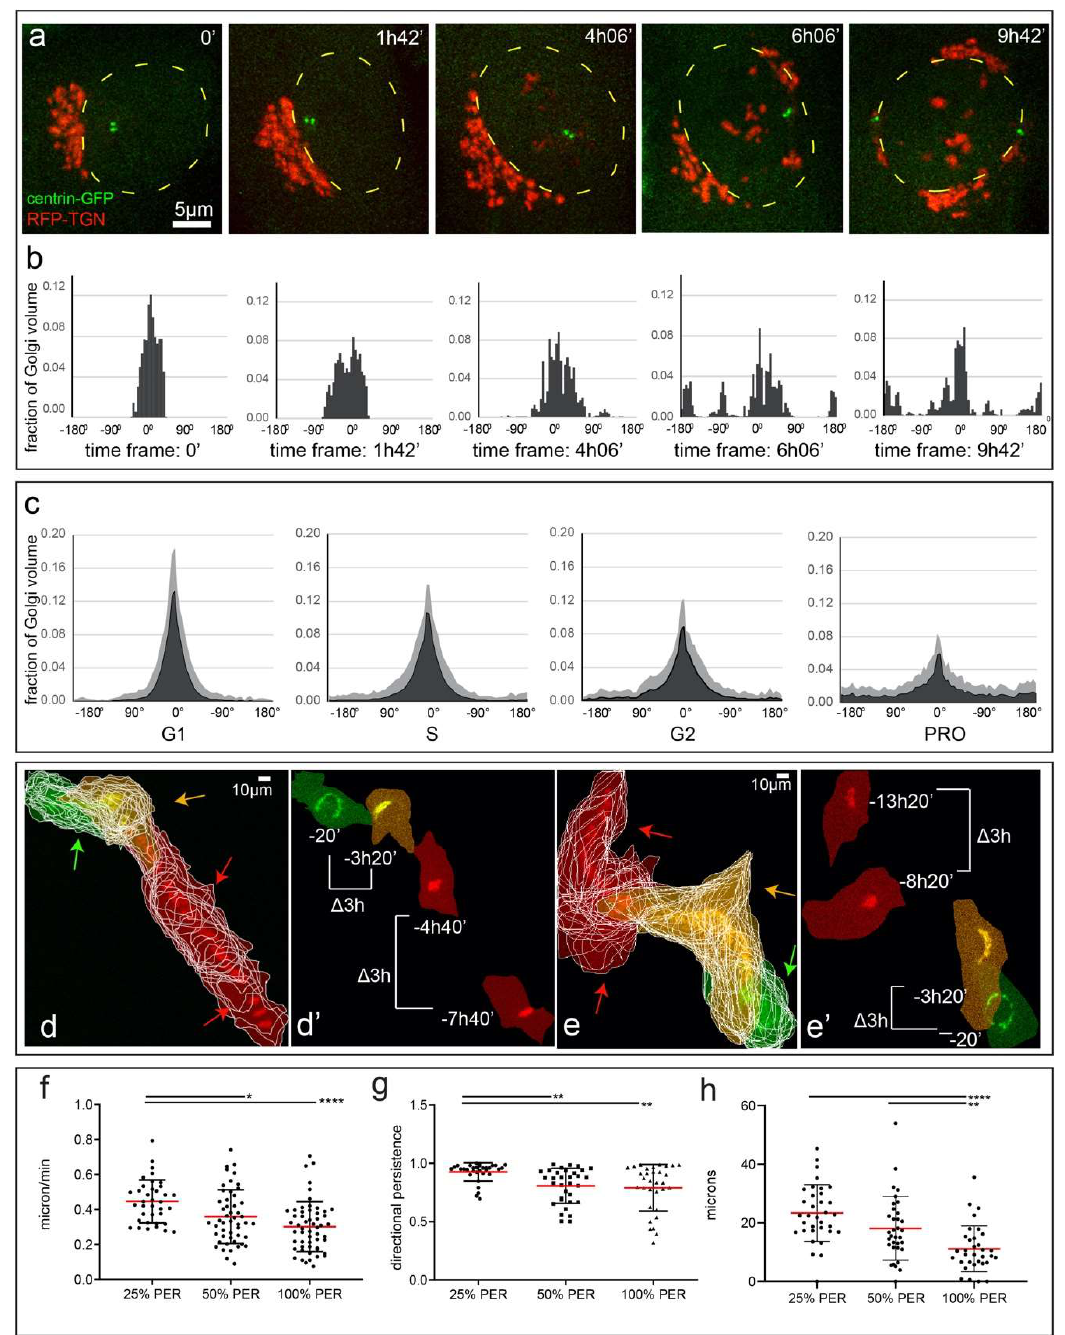
Figure 6. C1 Golgi compaction correlates with high cell migration speeds. ( a ) Frames from time-lapse imaging sequences of an RPE1 cell stably expressing Golgi (RFP-TGN, red) and centrosome markers (centrin1-GFP, green) during E mode progression. Yellow dotted lines indicate nucleus outline. Maximum intensity projections of laser scanning confocal stacks. Scale 5 µm. ( b ) Histograms of radial Golgi distribution in the cell shown in ( a ), corresponding to each timepoint above. Fraction of Golgi volume in 5-degree radial sectors are plotted. Angle 0 indicates the bin with the largest number of Golgi voxels. ( c ) Mean histograms of radial Golgi distribution per cell cycle stage for entire fixed cell population (as used in Figure 1b–d). SD is shown in light gray. ( d – e’ ) Overlaid frames from time-lapse epifluorescence imaging sequences of RPE1 cells stably expressing Golgi marker (RFP-TGN). Images are pseudo-color-coded according to Golgi configuration modes: compact Golgi (PER < 25%, red),